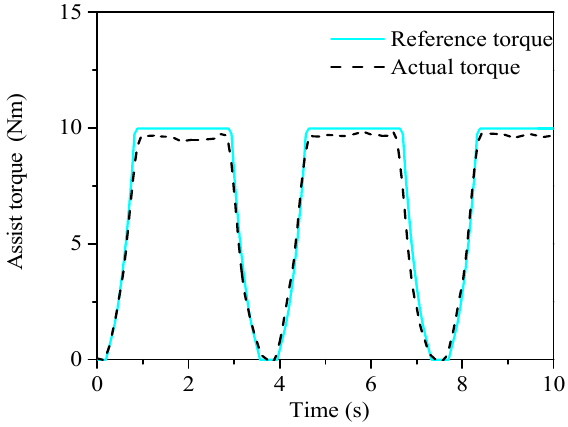
Figure 31. Actual torque at 20 km/h velocity under the proposed control algorithm.